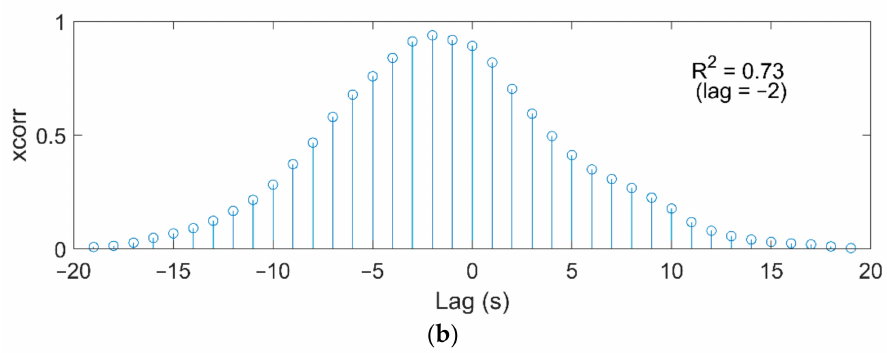
Figure 15. ( a ) The variation in significant wave height (SWH) and current variation (CV) at Zhoushan sea area (minus background current field). ( b ) The cross–correlation analysis diagram of SWH and